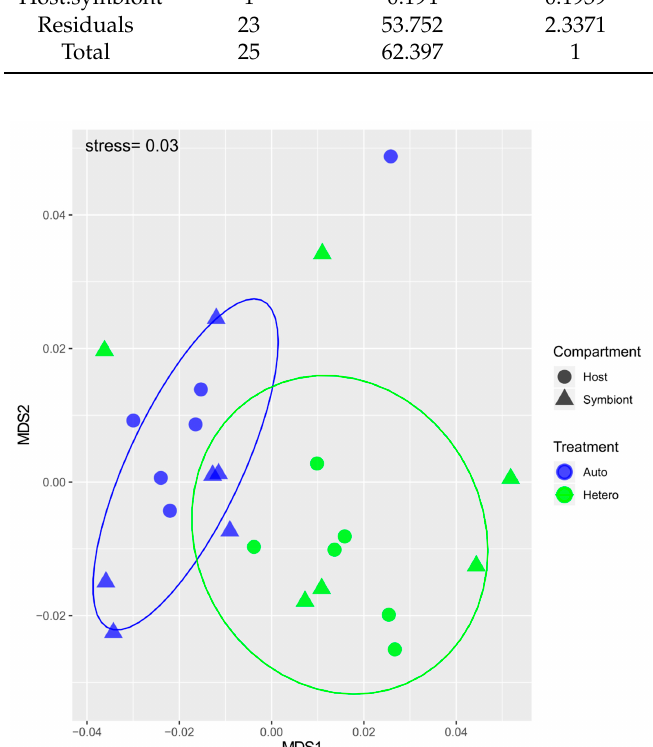
Figure 5. MDS performed with the δ 13 C value of the essential amino acids (Valine, Leucine, Isoleucine, Methionine, Phenylalanine) of autotrophic (blue symbols) and heterotrophic (green symbols) coral holobionts: host (circles) and symbionts (triangles). These data therefore include two nutritional treatments with two fractions, or 24 data points.